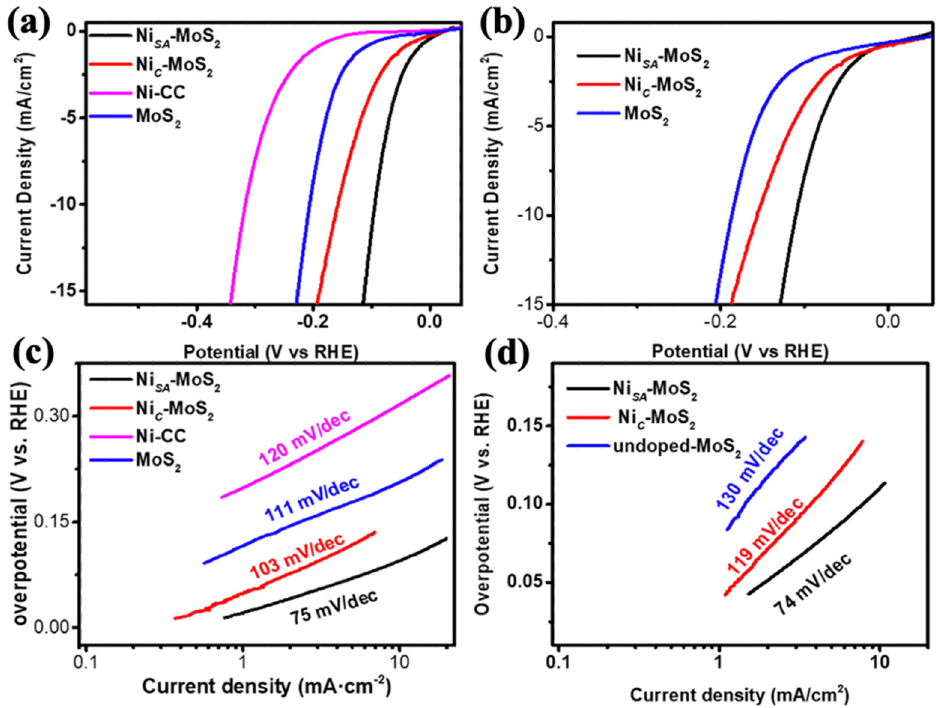
Figure 14. Polarization curves of NiSA-MoS 2 /CC catalyst in ( a ) 1 M KOH and ( b ) 0.5 M H 2 SO 4 solution with a scan rate of 5 mV s − 1 and ( c , d ) the corresponding Tafel plots. Reproduced from Elsevier [81].